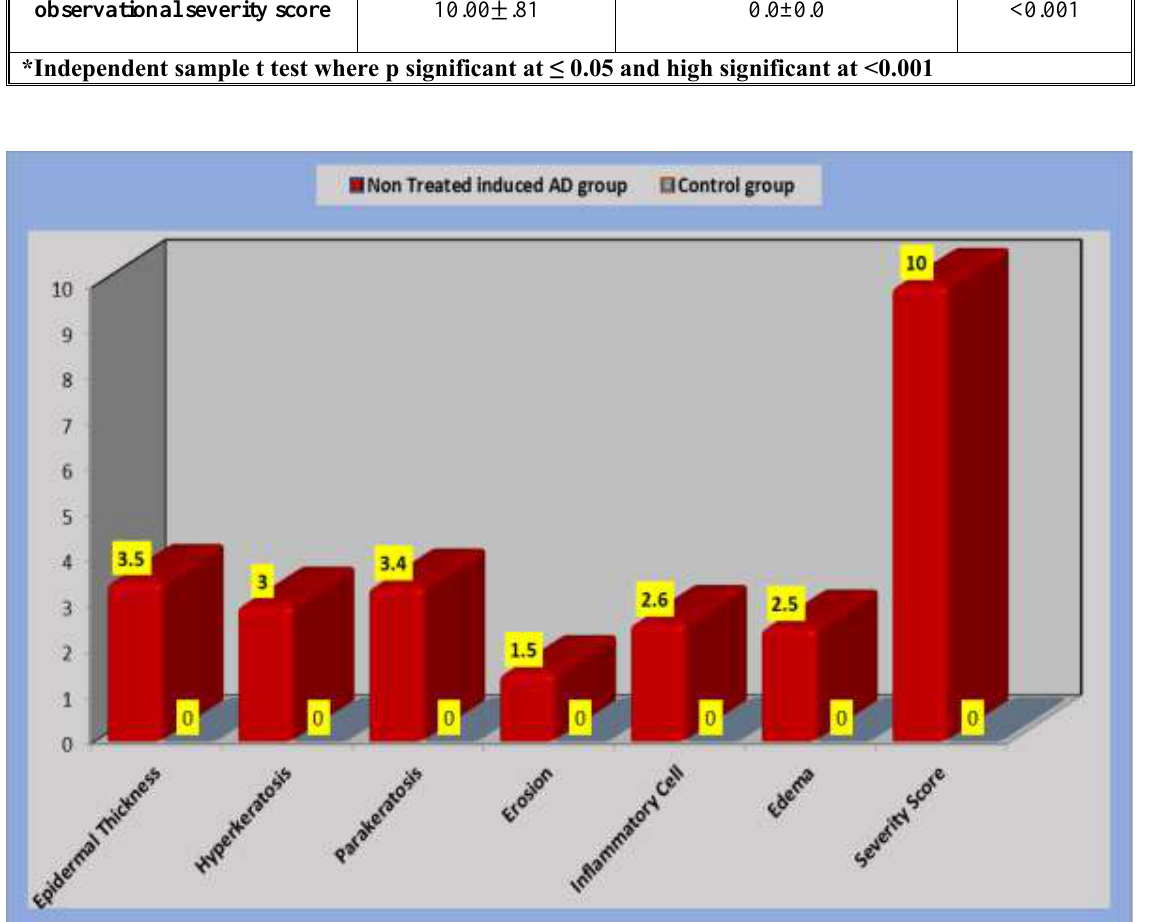
Figure 3. Comparison between means of controls and non-treated atopic dermatitis induced group regarding histopathological scores and Observational severity score; AD: atopic dermatitis; Results are expressed as mean ± SD, P is significant at ≤